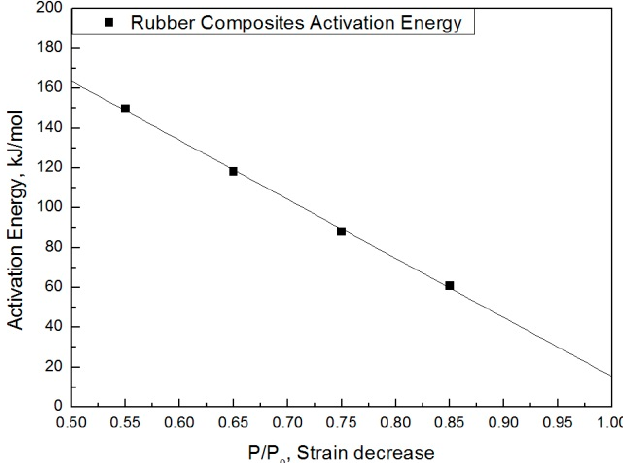
Figure 13. Activation energy according to the characteristic value.